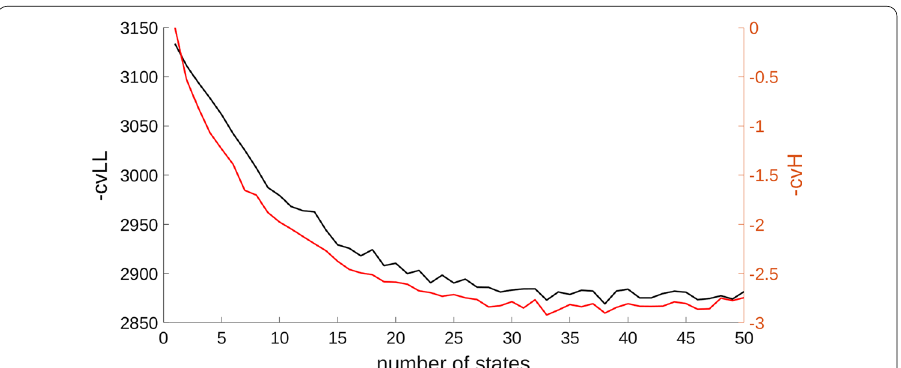
Fig. 3 Selection of the number of hidden states by minimising the negative cross-validated entropy. The axes show the negative cross-validated log-likelihood − cvLL (left) and negative cross-validated entropy − cvH (right). Qualitative similarities are evident between the two criteria suggesting deeper similarities between likelihood and entropy